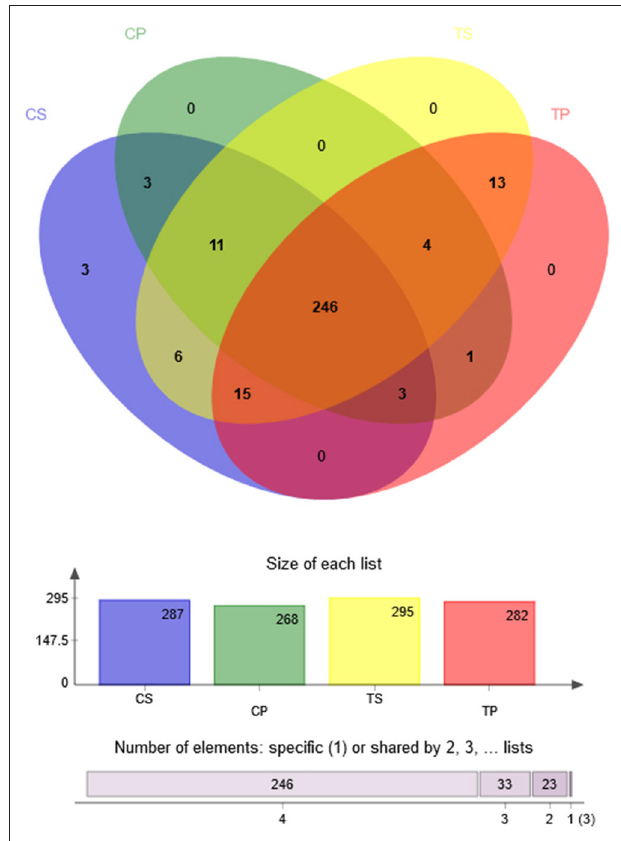
FIGURE 4 | Venn diagram at the species level. Different colors represent different groups. The overlaps represent the common taxa between groups, and the non-overlapping portions represent unique taxa in each group.